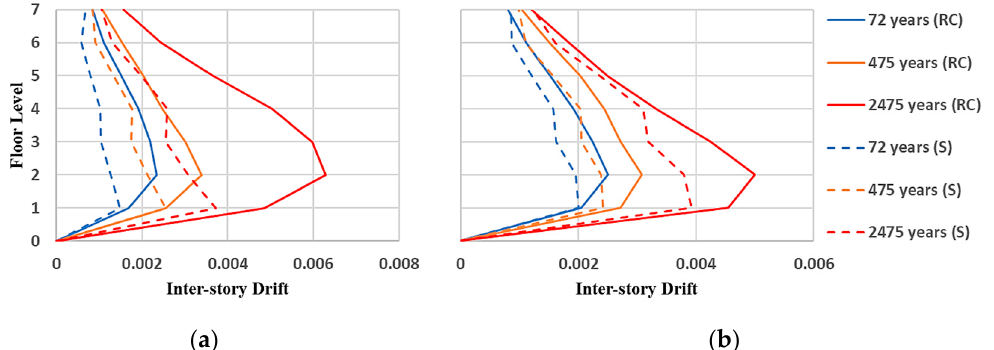
Figure 9. ( a ) Culiacan, Sinaloa, ( b ) Villahermosa, Tabasco. Mean of the maximum inter-story drift response for each level of the steel and reinforced concrete structural model for seismic zone B.